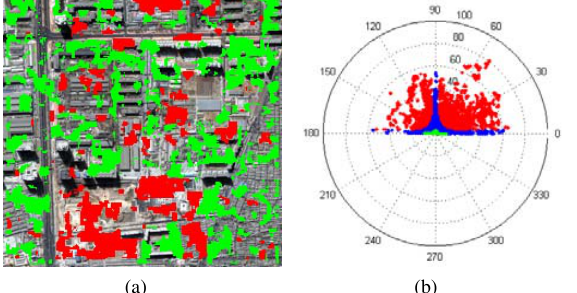
Figure 8: Automatic sample selection. (a)initial training samples selected by the proposed approach. (b)visualization of training samples in polar